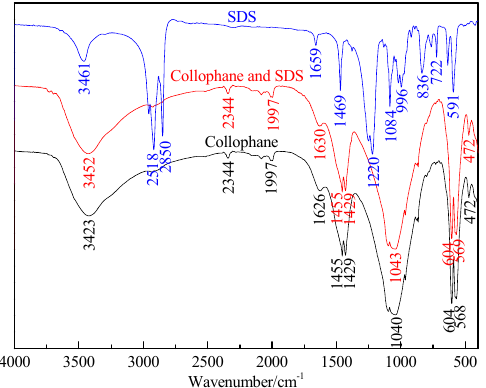
Figure 10. FTIR spectra of before and after action between dolomite and SDS.